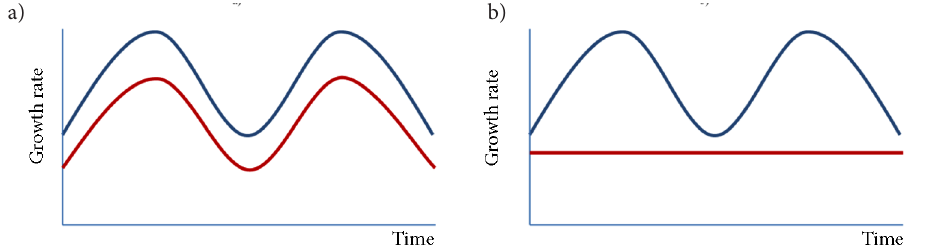
Note : red line–threshold separating fast growing firms from other growing firms; blue line–growth rate of fastest growing firms. Figure 2. (a) Identification of fast-growing firms as a distinct upper share of all growing firms; (b) identification of fast-growing firms as those with growth exceeding a specified